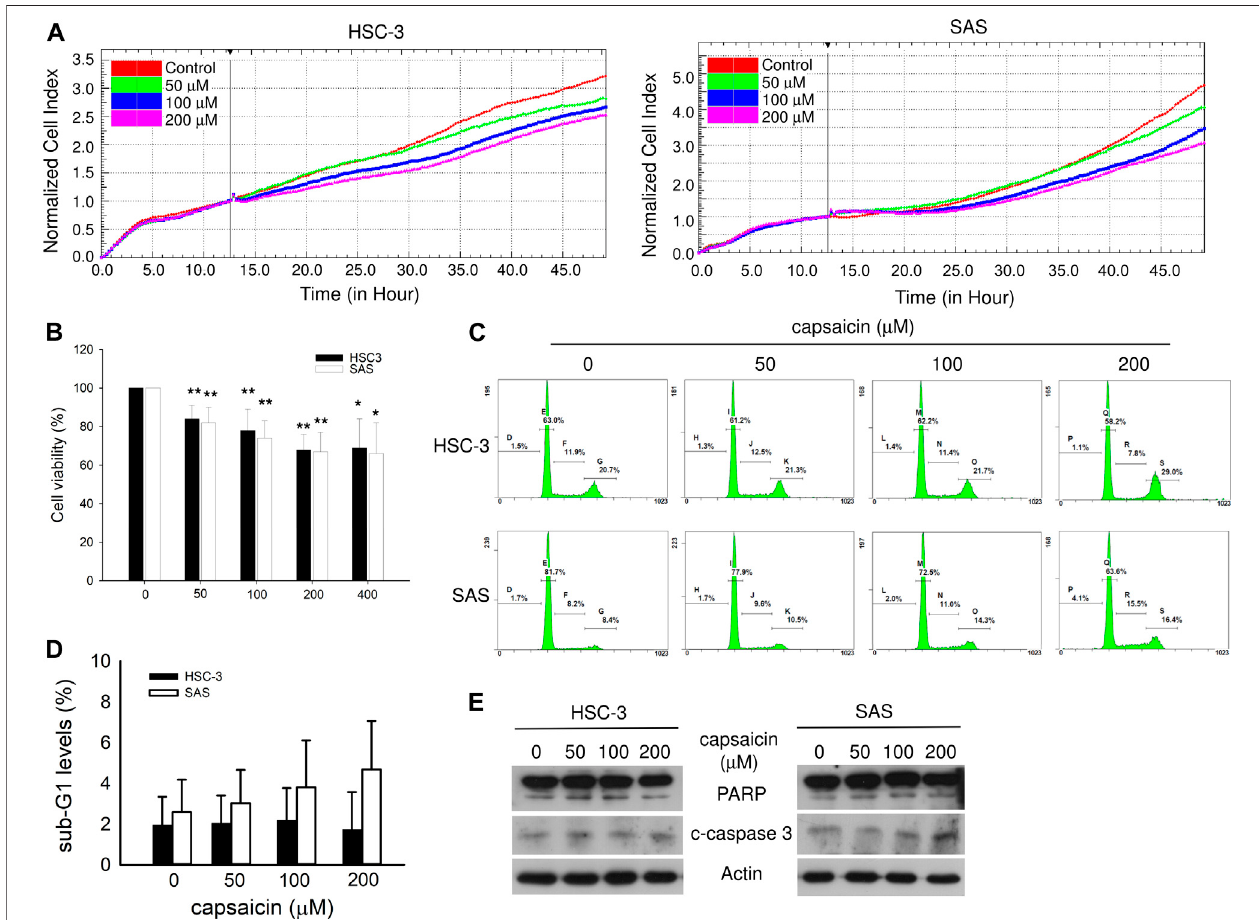
FIGURE 1 | Effect of capsaicin on oral cancer cell growth and apoptosis. (A) The cell proliferation of HSC-3 and SAS cells treated with different concentrations of capsaicin, as measured by RTCA. (B) Cell viability after capsaicin treatment for 48 h was assayed by Cell Counting Kit-8 (CCK-8). (C,D) The levels of apoptosis after capsaicin treatment for 48 h were analyzed by fl ow cytometry, and apoptosis-related proteins were detected by Western blot analysis (E) . Data are representative of three to six independent experiments.